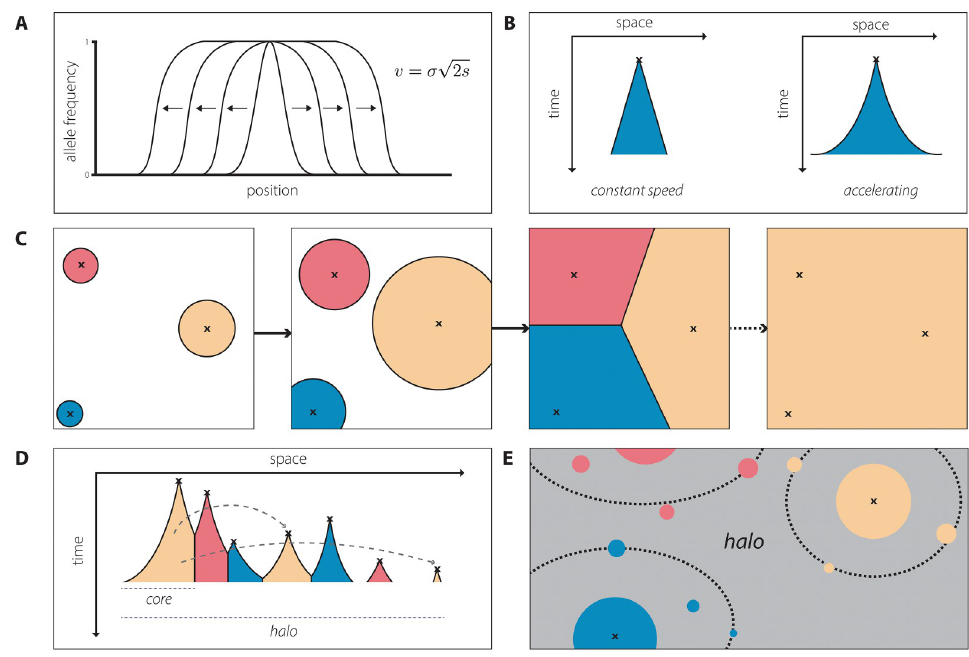
Fig 2. Summary of reviewed spatial models. (A) Schematic of Fisher’s wave of advance in one dimension [19]. (B) Space-time diagrams under regimes of constant vs. accelerating dispersal [22]. (C) Cartoon representation of parallel adaptation resulting in a tessellation-like pattern of genetic variation (as under the allelic exclusion assumption in [22]), followed by the later fixation of a single allele (as resulting, for instance, from a change in the adaptive landscape favoring a single allele present from standing variation). (D) Space-time diagram under the parallel exclusion assumption [22,23]. (E) Cartoon of the core-halo structure identified by [23] for spatial soft sweeps under long-distance dispersal.